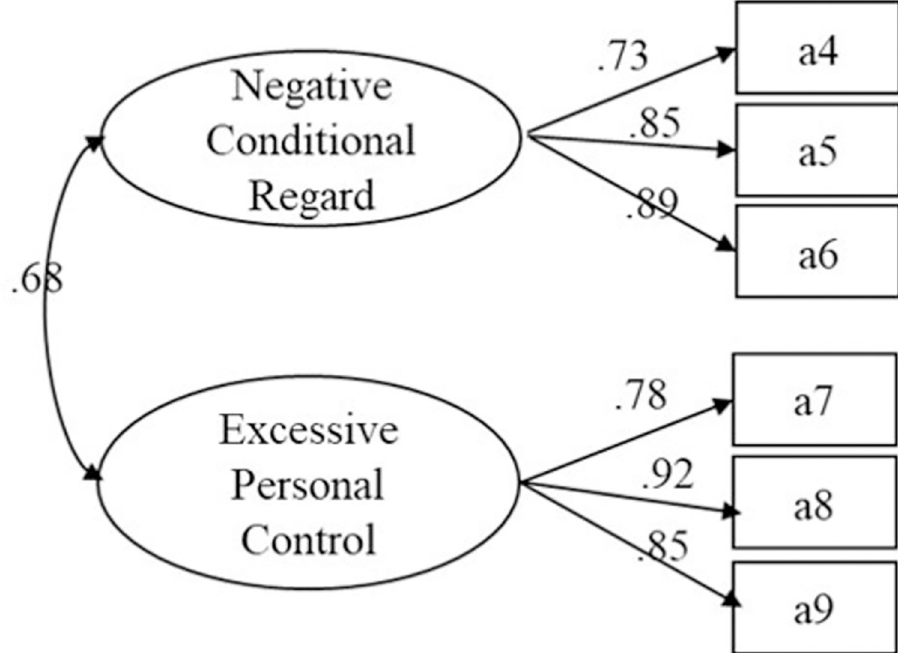
Fig 2. Results of two-factor confirmatory factor analysis of the Controlling Coach Behaviors Scale.